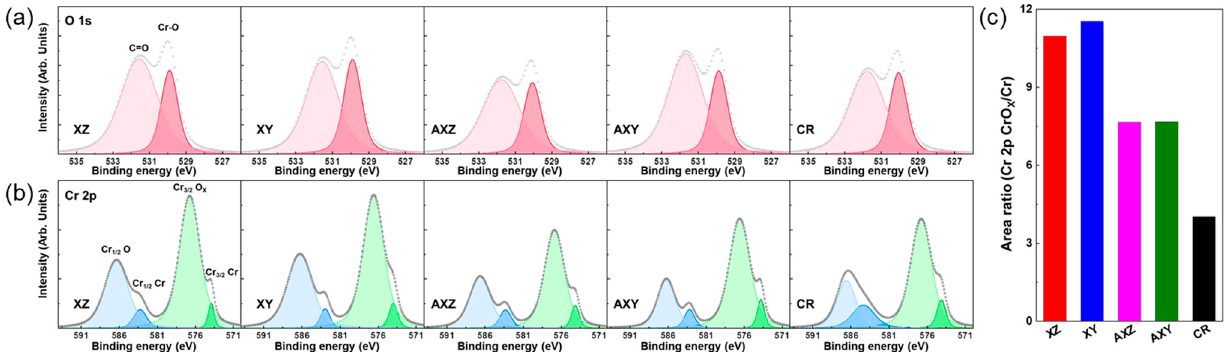
Figure 5. XPS core level spectra of ( a ) O 1s and ( b ) Cr 2p of XZ, XY, AXZ, AXY, and CR samples. The colored line shows peak-deconvoluted bands. The Me-O (530.6 eV) related peak of XZ and XY showed a higher oxide ratio compared with the other samples. ( c ) Represents fitted peak area ratio of oxide-related and metal-related peaks of Cr 2p. XZ and XY have a higher oxide formation ratio compared with AXZ, AXY, and CR.